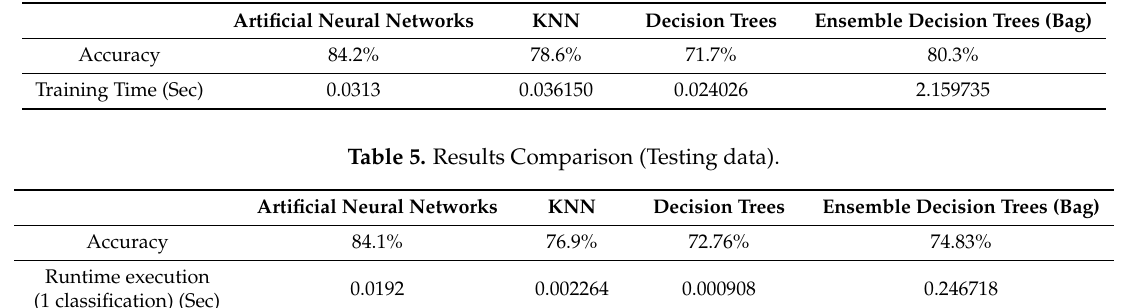
Table 4. Results Comparison (Training data).